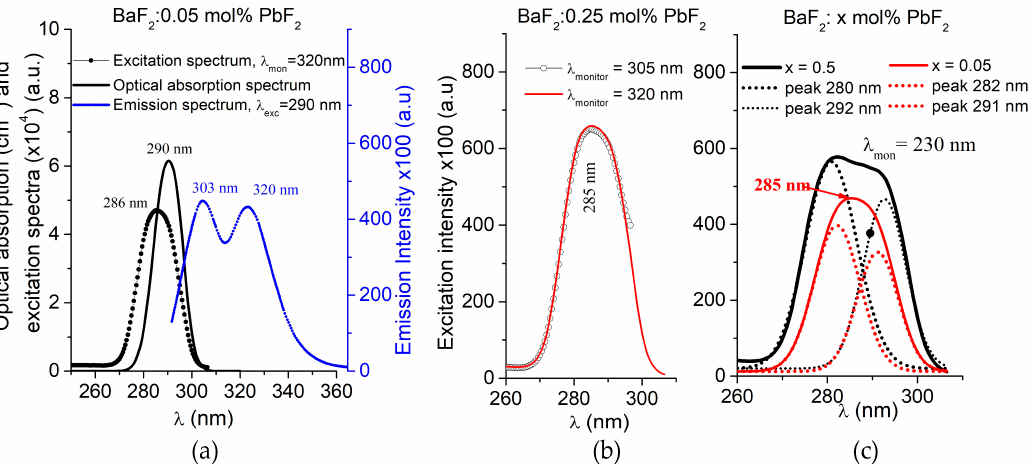
Figure 12. ( a ) Optical absorption spectrum, the excitation spectrum monitored for the 320 nm emission peak and the emission spectrum under excitation in the A band (290 nm) is also shown; ( b ) excitation spectra of BaF 2 :0.25 mol% PbF 2 sample monitored for 305 nm and 320 nm emission peaks; ( c ) Gaussian multi-peak fitting of the excitation spectra ( λ monitor = 320 nm) of two samples with different PbF 2 content.